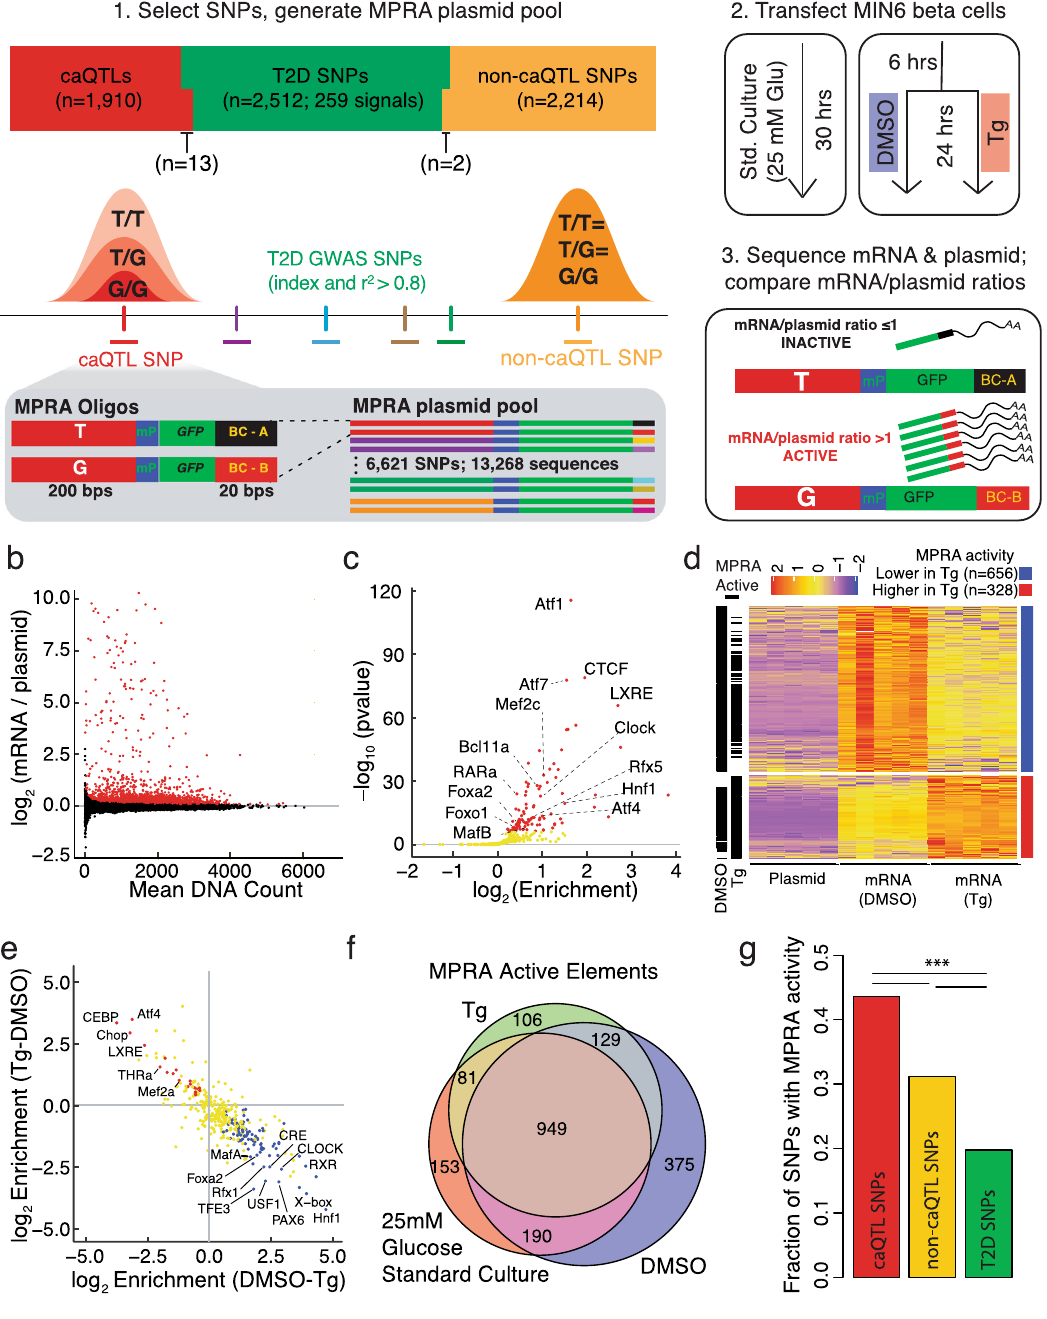
potential of human